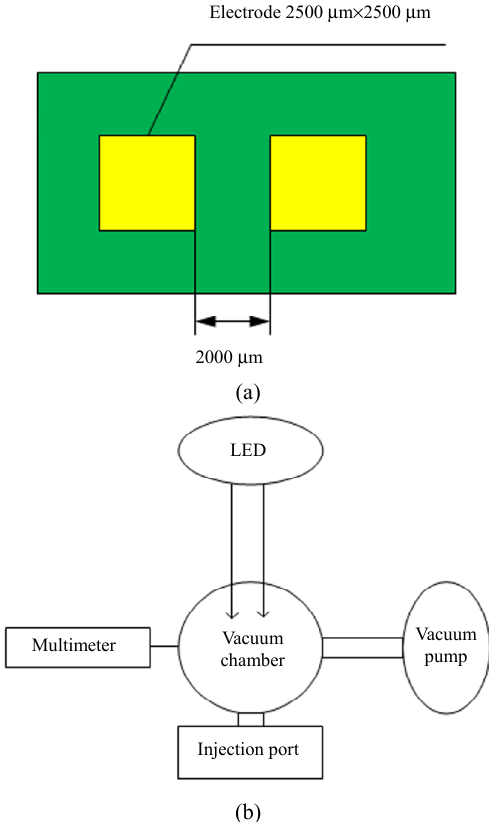
Fig. 2 Schematic diagram of the electrode pattern and gas-sensing test system: (a) electrode pattern and (b) gas-sensing test